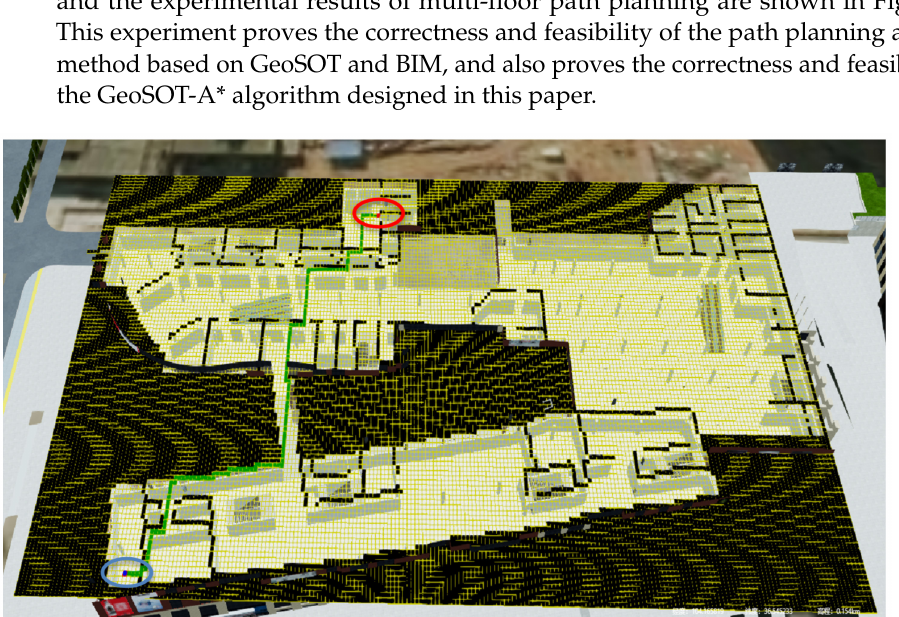
Figure 15. Single-floor path planning.